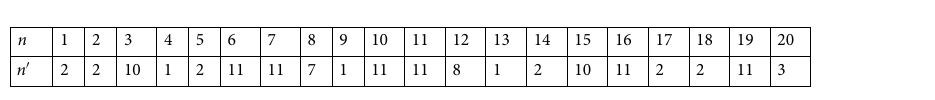
Table 1. Optimized graphene chemical potential ( n ′ ) selections.